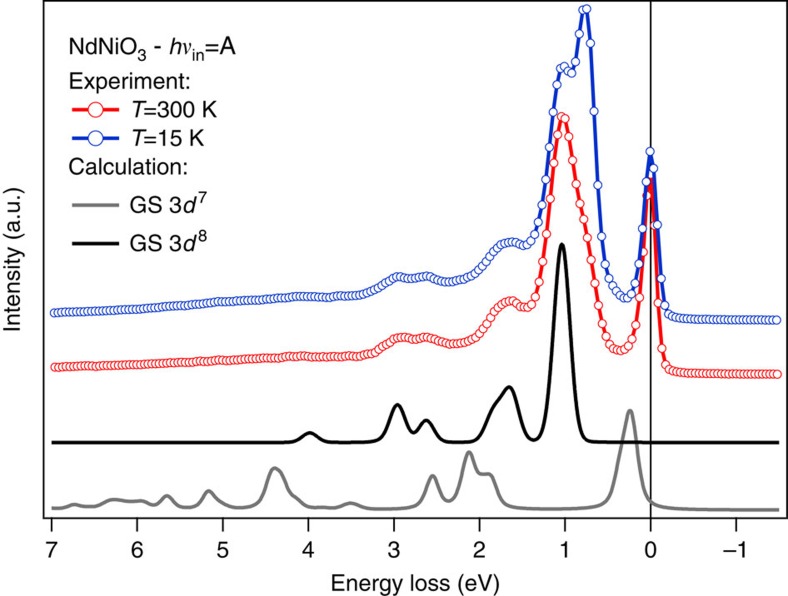
Comparison between experimental and calculated dd-excitations.Data: RIXS spectra at T=15 K (blue circles) and at T=300 K (red circles), hνin=A, σ polarization. Calculation: crystal field RIXS calculation for a Ni 3d8 GS based on NiO parameters45 (black line); cluster calculation for a Ni 3d7 GS using the parameters in ref. 39 (grey line). Please note that the elastic lines have been removed from the calculated spectra to better display the differences at the low energies. The experimental dd-line shape is well reproduced by the Ni 3d8 cluster calculation, supporting the negative charge-transfer scenario for ReNiO3. The good matching between data and calculation shows that: (1) there is no inversion of crystal field in ReNiO3 compared with NiO, in agreement with ref. 25 for dominating Coulomb interaction; (2) being the Ni–O distance shorter in ReNiO3 than in NiO, the negative charge-transfer energy may lead to a reduction of the expected t2g-eg splitting.